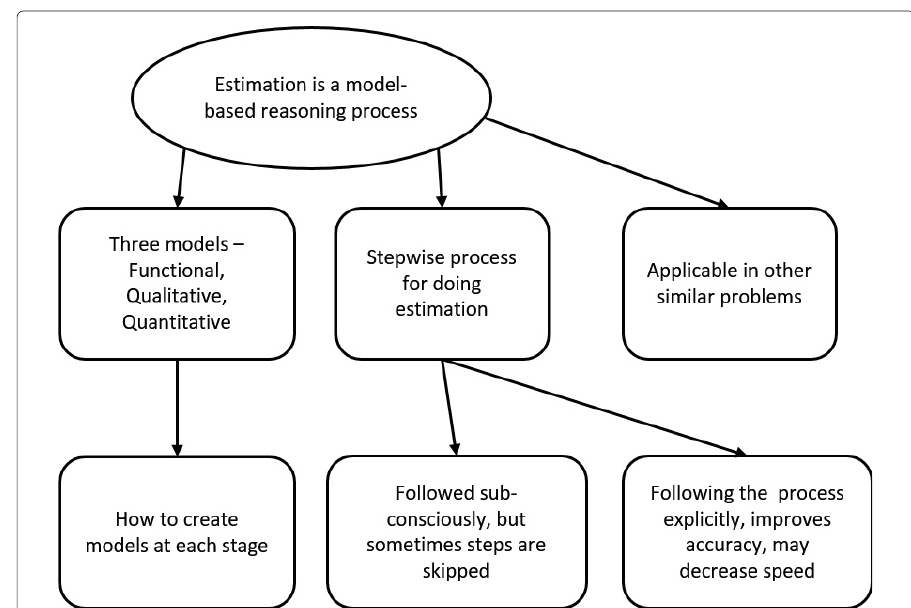
Fig. 7 Analysis map of Theme 1. This figure shows the themes identified within Theme